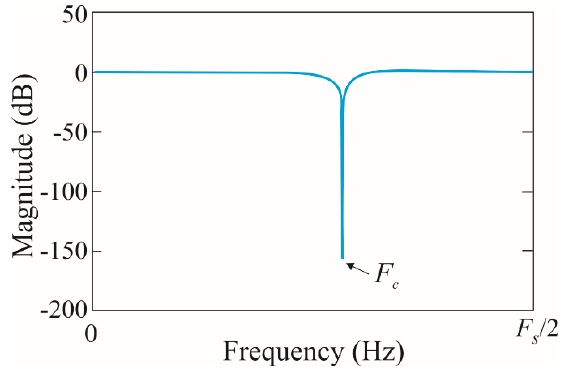
Figure 2. Frequency response of a notch filter with cutoff frequency Fc and a sampling frequency Fs . Sensors 2020 , 20 , x FOR PEER REVIEW